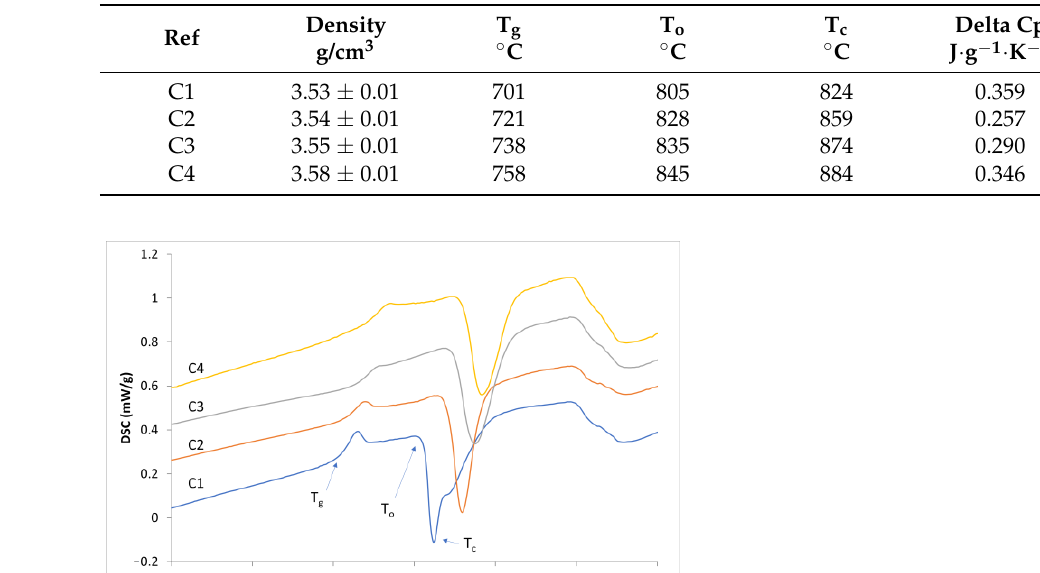
Table 2. Properties of the parent glasses C1, C2, C3 and C4.